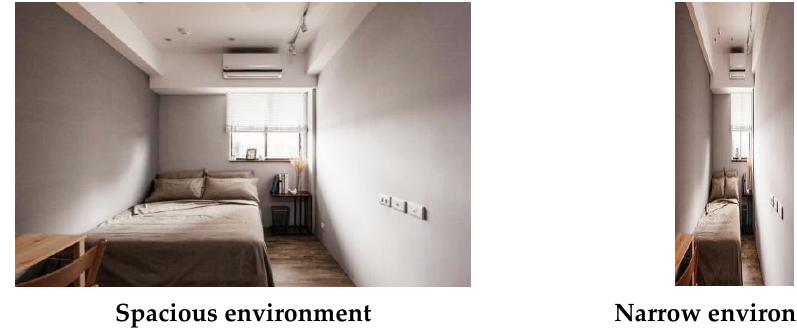
Figure 3. The phonographs of spacious environment and narrow environment.